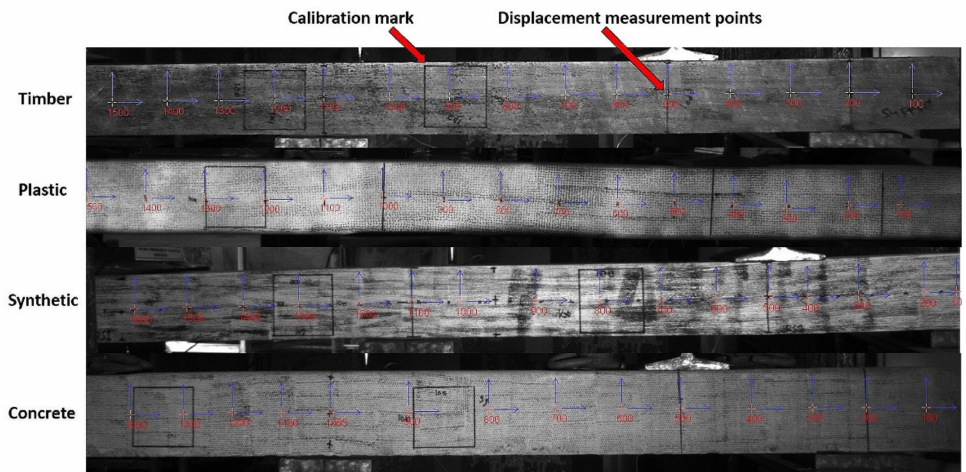
Figure 8. Digital Image Correlation (DIC) images of the sleepers showing displacement points (neoprene support at